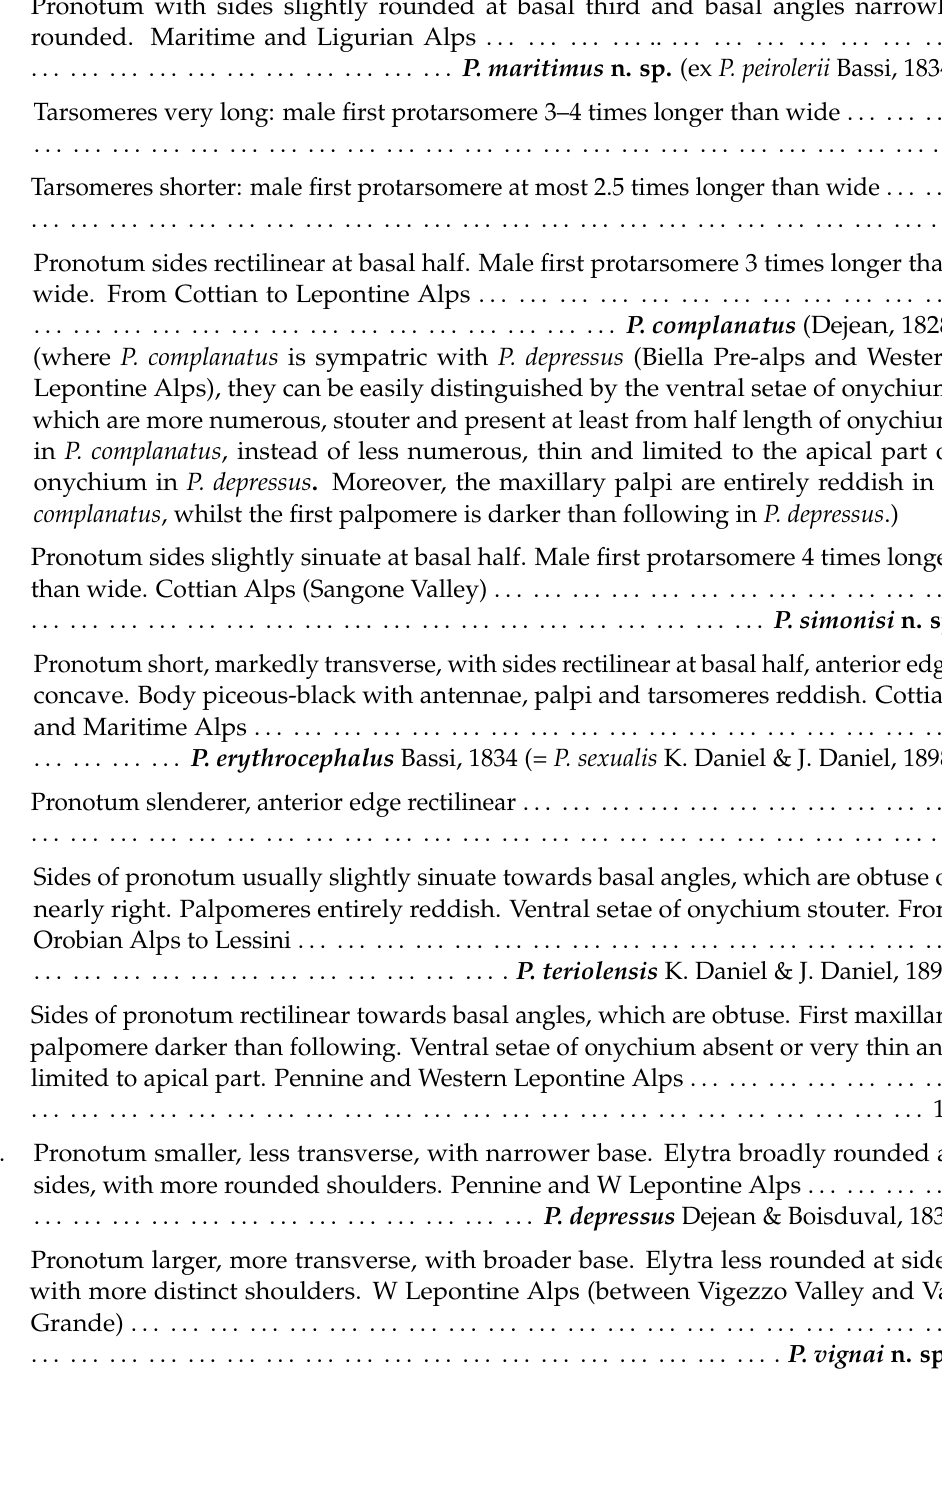
Tarsomeres very long: male first protarsomere 3–4 times longer than wide . . . . . . . . . Tarsomeres shorter: male first protarsomere at most 2.5 times longer than wide . . . . . . 7. Pronotum sides rectilinear at basal half. Male first protarsomere 3 times longer than